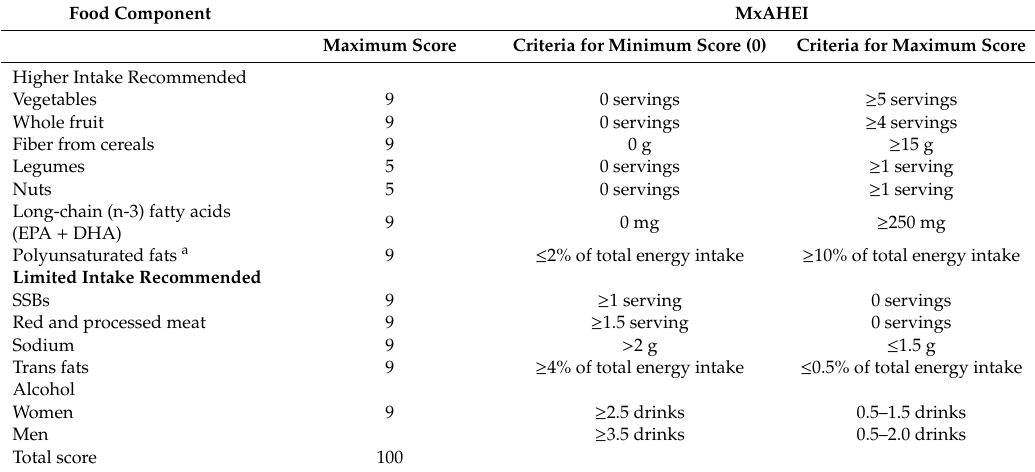
Table 1. Mexican Alternate Healthy Eating Index. Components and scoring criteria. Food Component MxAHEI Maximum Score Criteria for Minimum Score (0) Criteria for Maximum Score Higher Intake Recommended Vegetables